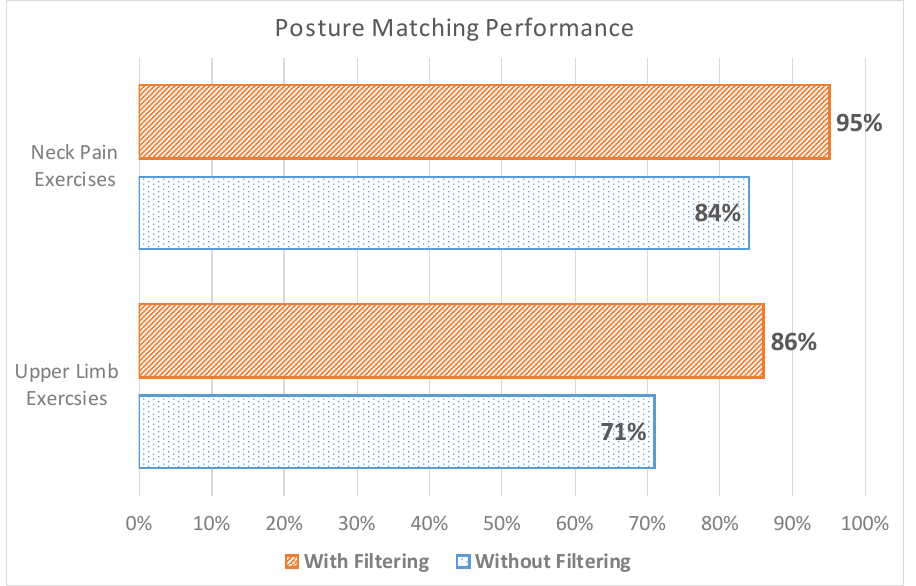
Figure 14. Posture matching accuracy performance before and after